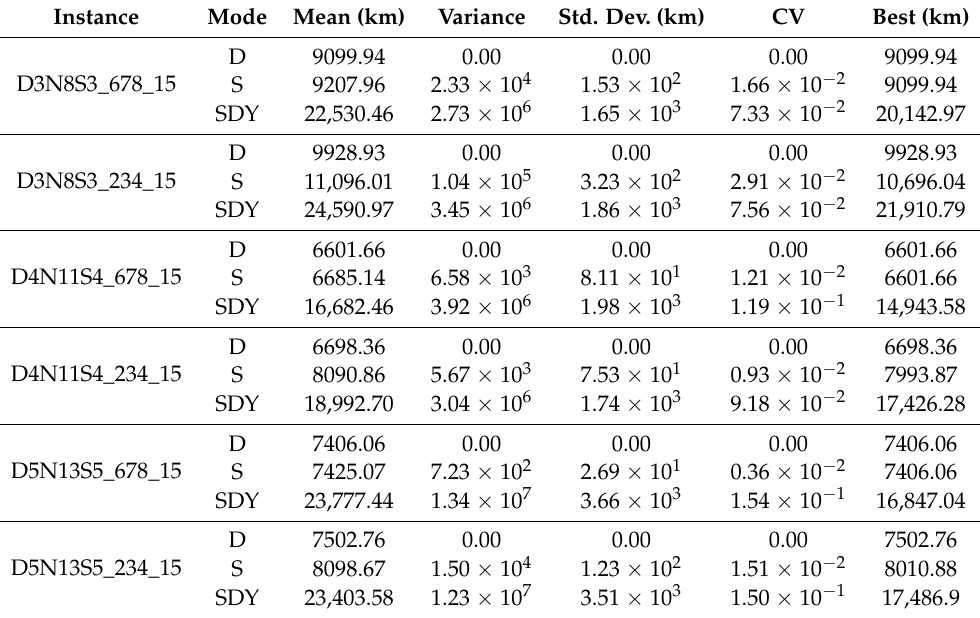
Table 5. Results of Total Distance Travelled with (Maximum) 15 Vehicles.